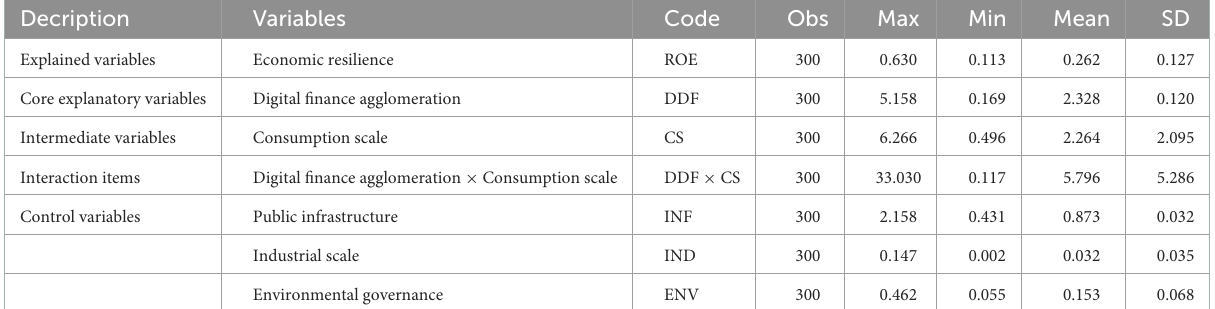
TABLE 3 Statistical description of